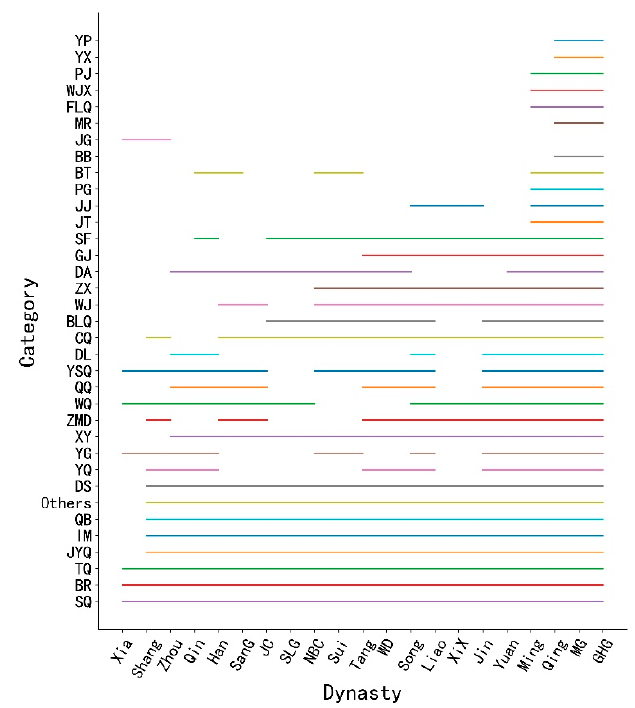
Figure 1. “Life Cycle” diagram of cultural relics.